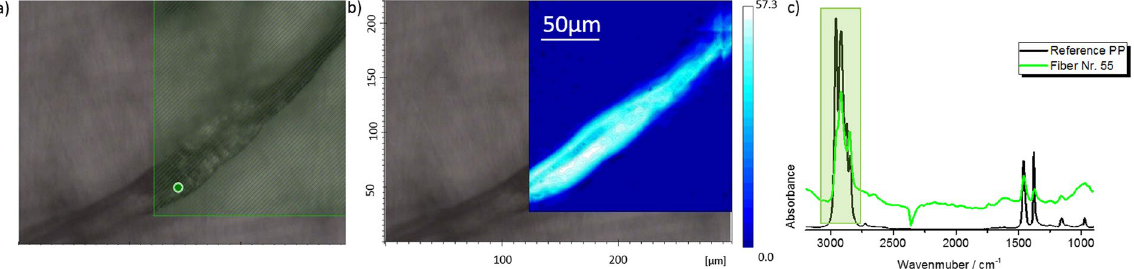
Figure 6. Optical image and spectra of an aerial fibre identified as polypropylene. The figure shows an optical image ( a ) with a corresponding FTIR chemical image integrated at 2800–3000 cm − 1 ( b ). Image c is showing a fibre spectra (green) with its corresponding spectra (black; PP reference).